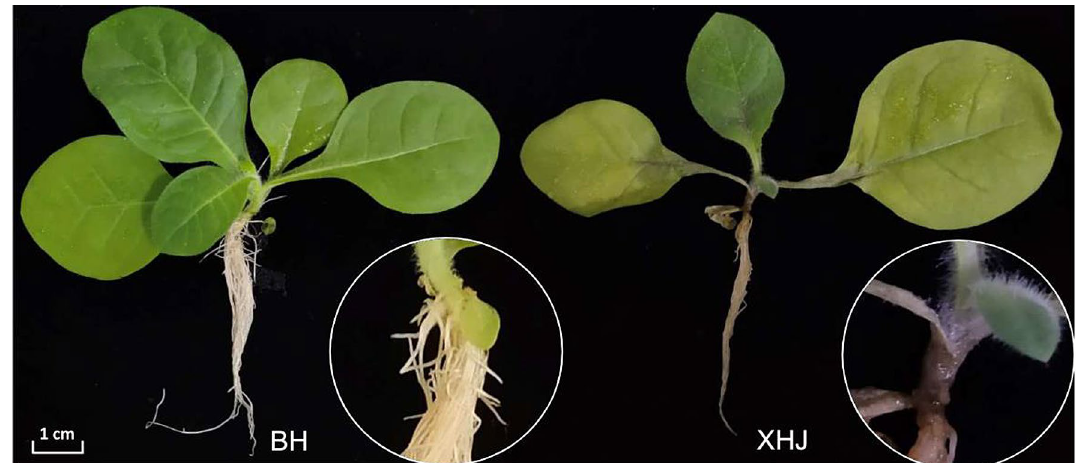
Figure 1. Disease symptoms in the cultivars BH (resistant) and XHJ (susceptible) at 5 dpi by Phytophthora nicotianae . The basal parts of stems are magnified and shown in the circles. In BH (Left), no symptoms were apparent. In XHJ (right), leaves were withered and the basal part of stem was severely necrosed and became